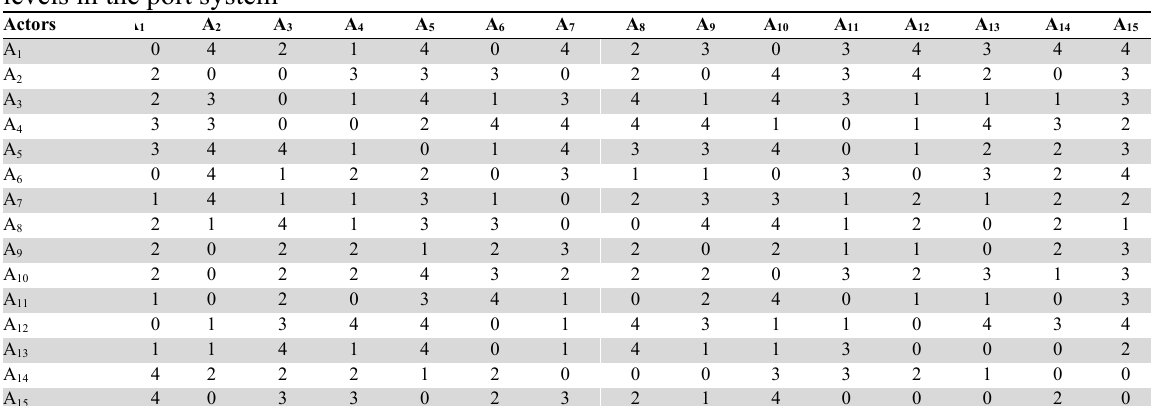
Fig. 3 contains the application of the DEMATEL model criteria, showing that: if D-R values are greater or equal to zero, port actors become the cause of influence over other port actors, and if D-R values are